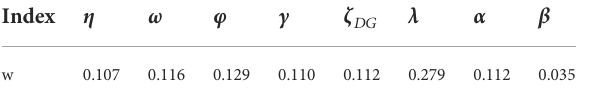
TABLE 7 The weight of assessment indexes of the